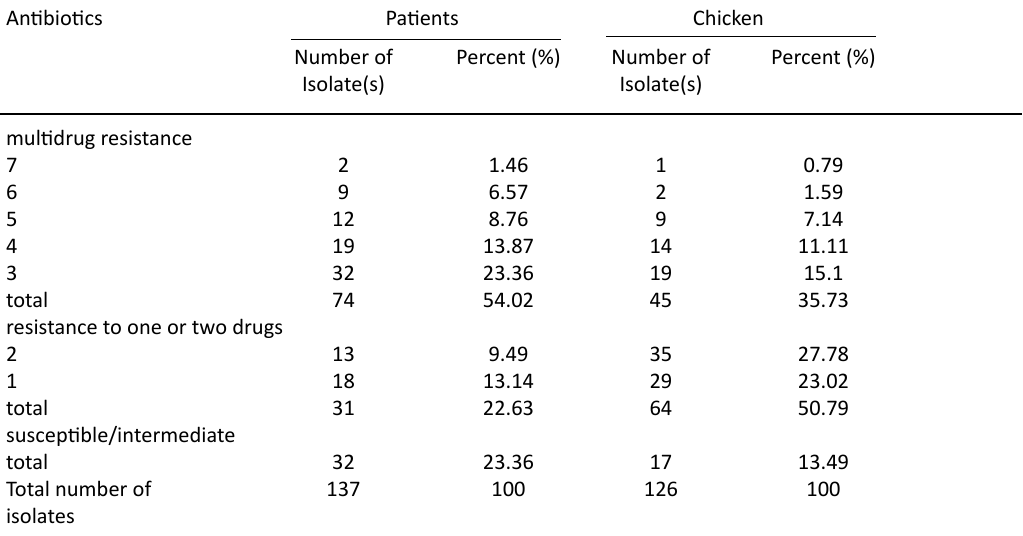
Table 5. Number of Salmonella strains from patients and chicken meat in Thailand resisted to antibiotics Antibiotics Patients Chicken